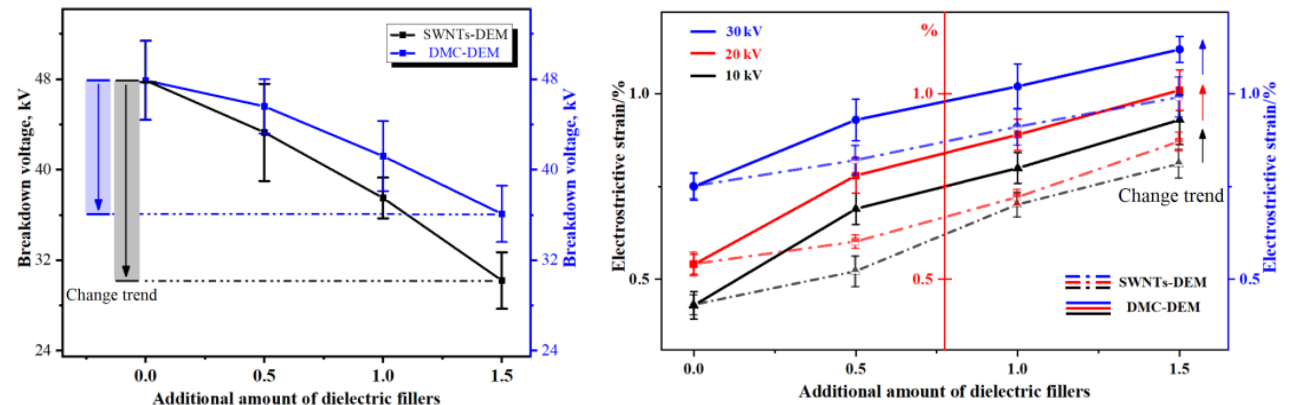
Figure 9. Electrical deformation properties of series polyurethane composite fiber membranes.